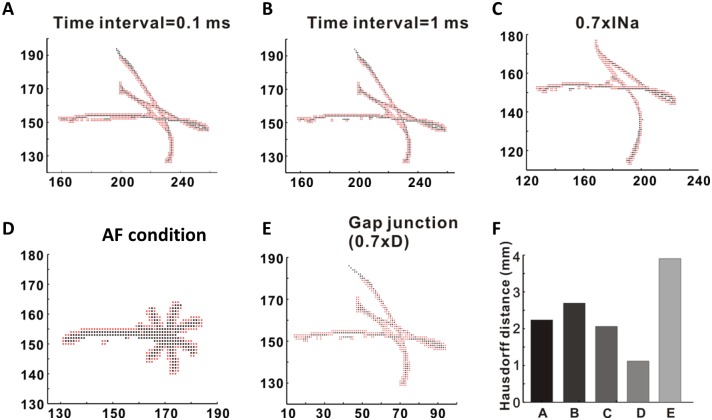
Parameter effects on PS calculation between the two methods.(A) and (B) show overlapped PS points found using the two methods in control condition (red: Iyer-Gray method; black: location-centric method) at two sampling time intervals (0.1 ms and 1 ms). We investigated the effects of electrical remodeling on PS detection: 0.7×INa (30% reduction in Na+ channel conductance) (C), AF condition, and 0.7×D (30% reduction in gap junctional coupling). For the AF condition, we applied the same condition that was used in our recent paper [19]: INa (−10%), Ito (−70%), ICaL (−70%), IKur (−50%), SR Ca2+ leak (+25%), IK1 (+100%), INaCa(max) (+40%) (D). For the change in the gap junctional coupling caused by changing 0.3×D (E), we found that HD was 3.9 mm, which was the largest among five examples (F).